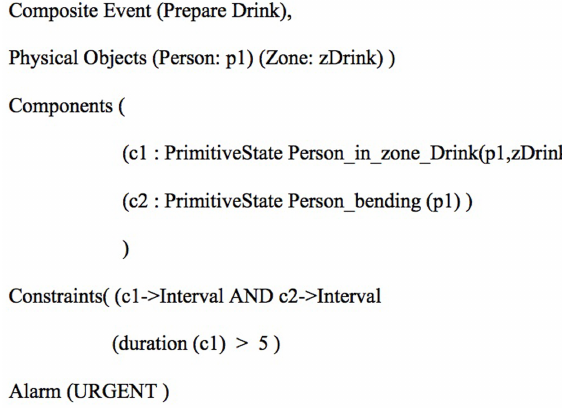
FIGURE 1 | System architecture; this figure shows the different steps from the system receiving the video input to the definitive clinical diagnosis . The event monitoring system (EMS) consists of four modules that will lead to the correct assessment based on automatically extracted video features: